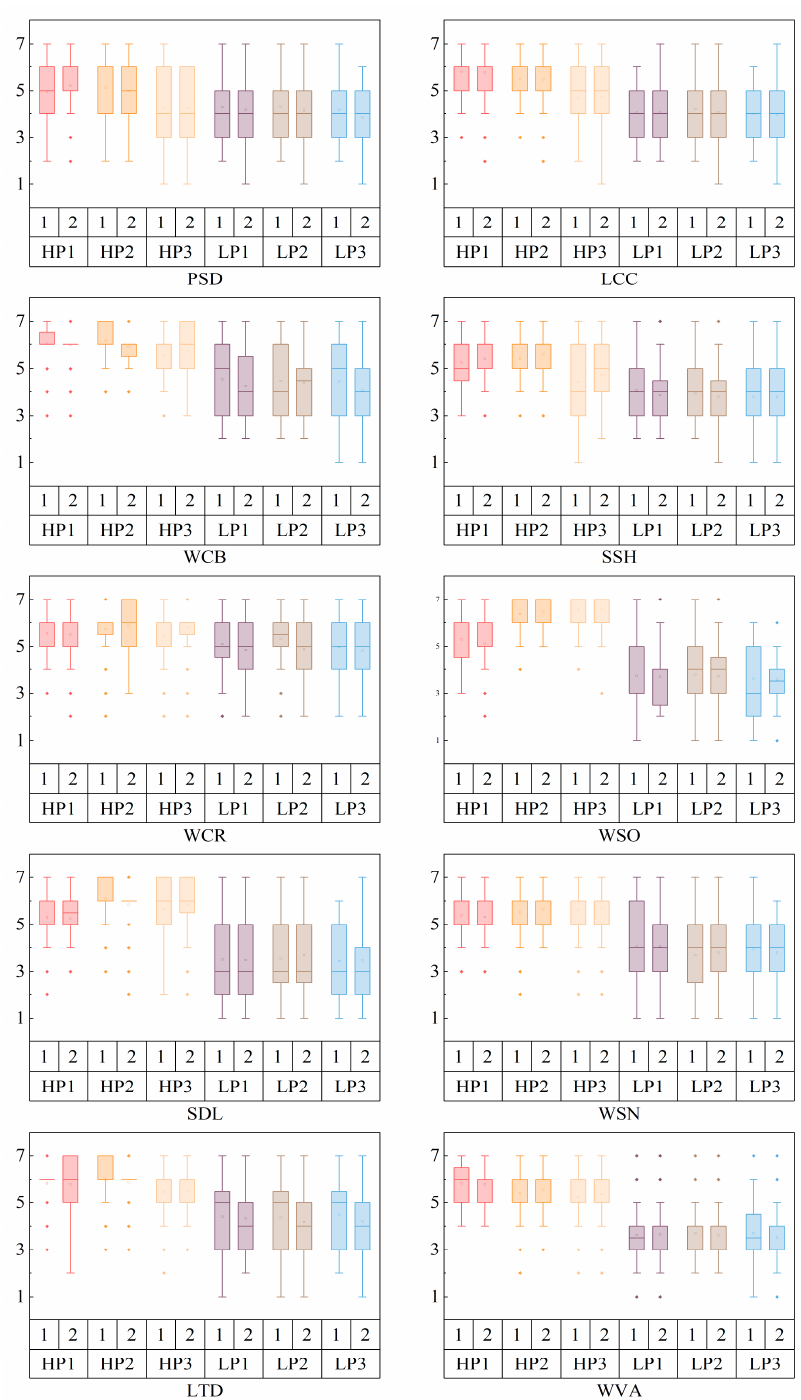
Figure 8. Cognitive evaluations of landscape spaces when repeatedly viewing. Note: PSD: Whether